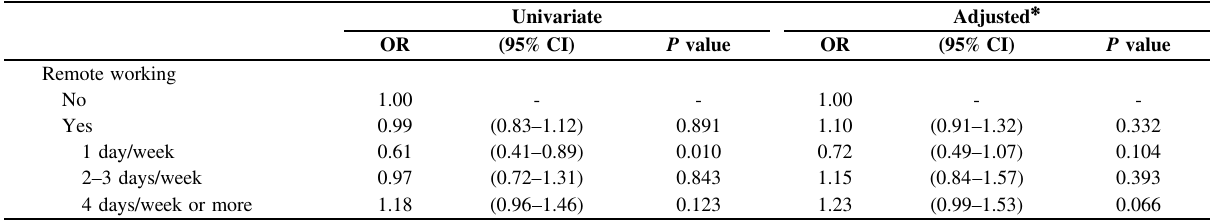
Table 2 Association between the frequency of remote working and loneliness among desk workers (n = 13,468) Univariate